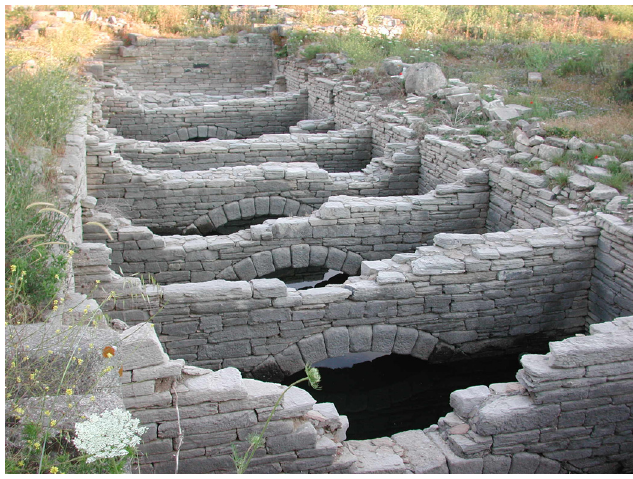
Figure 5. Central cistern on island of Delos (by G.P. Antoniou).